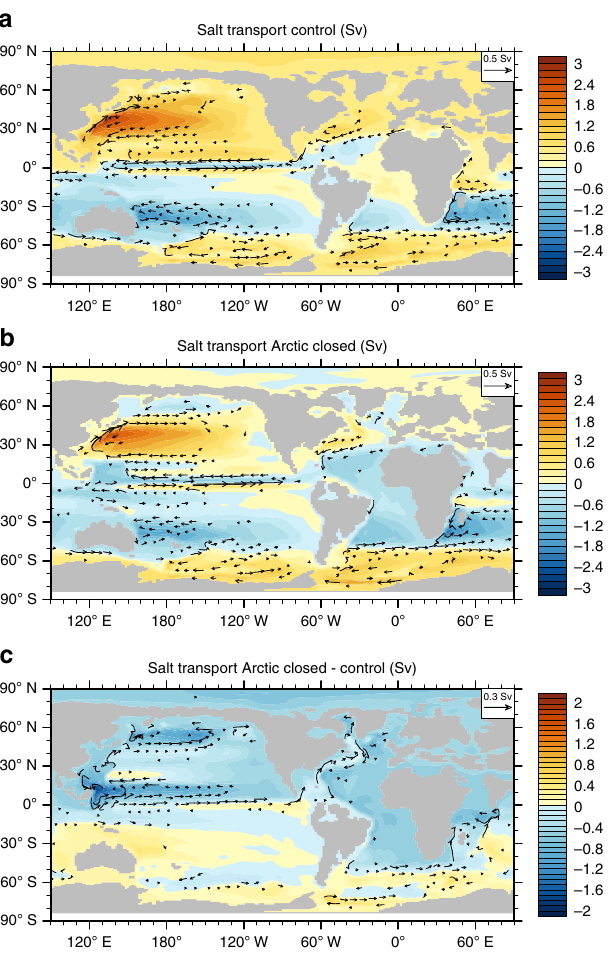
Fig. 4 Depth-integrated salt transport streamfunction. a The control experiment, b the Arctic Closed experiment and c the difference between Arctic Closed — Control. Contour intervals are 0.2 Sv, while transport vectors are drawn above a threshold magnitude of 0.05 Sv in a , b and 0.03